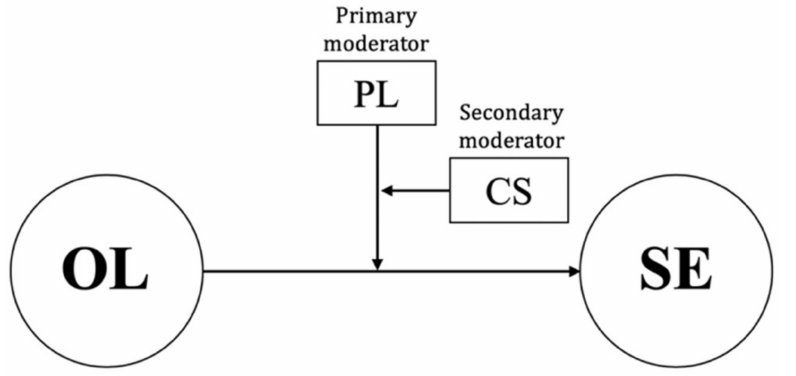
Figure 1. A moderated moderating model. OL, observational learning; SE, self-efficacy; PL, perfor- mance level; CS, competition